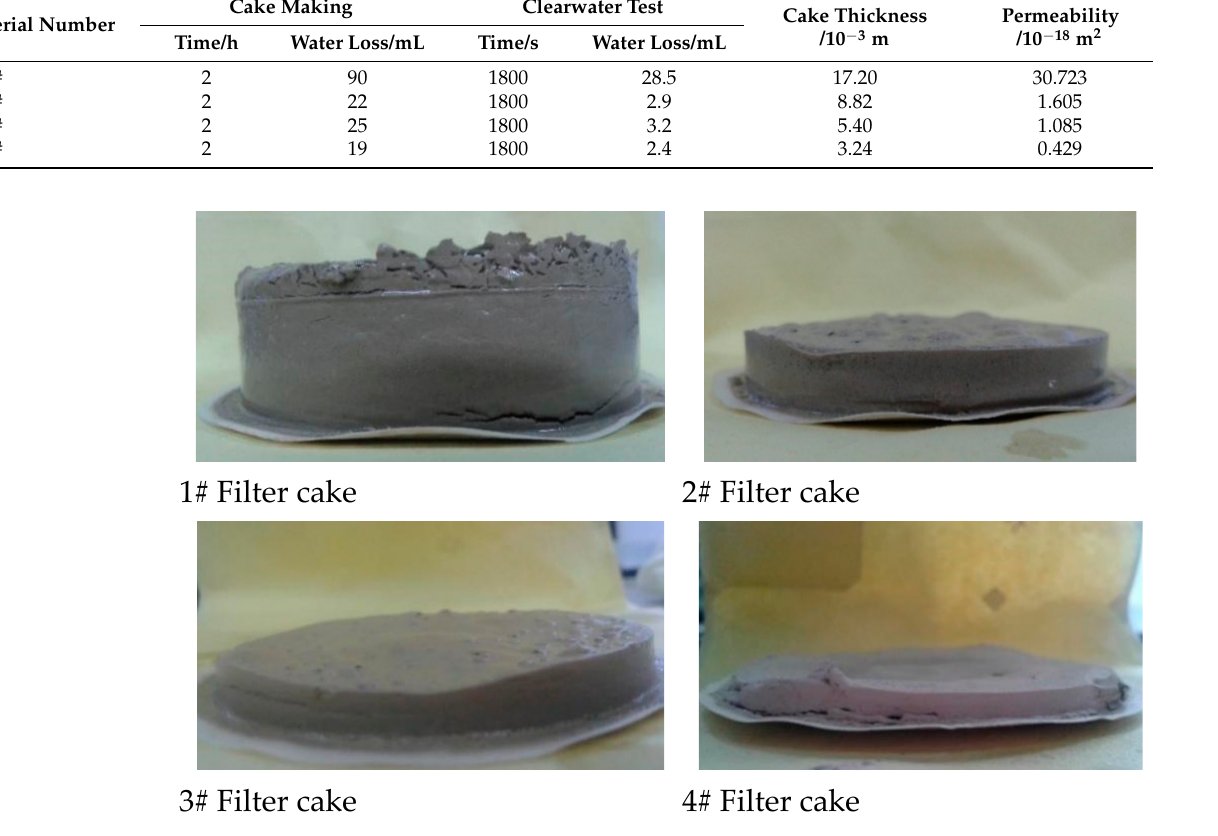
Figure 2. Filter cake diagram under different compound barite conditions. Next, the ratio of viscosifier polyacrylamide to sodium polyacrylate in the mud cake base paste was varied, and the experimental results are shown in Table